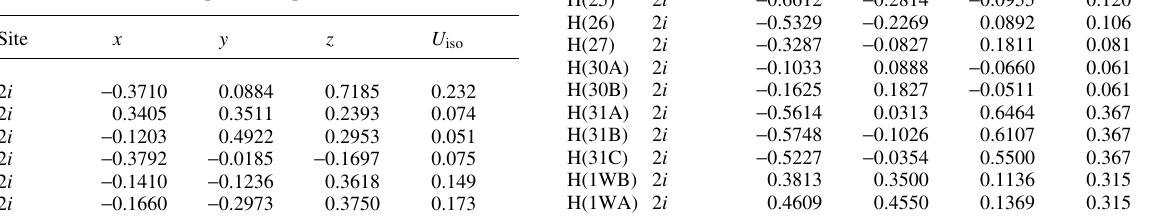
Table 2. Atomic coordinates and displacement parameters (in Å 2 ) .